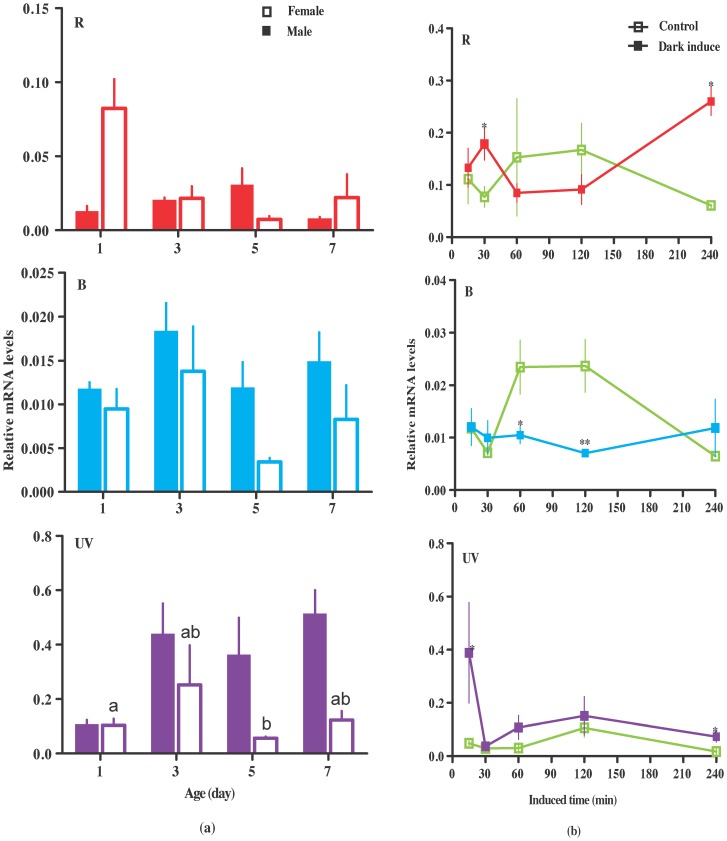
Relative expression level of R, B and UV opsins at different day instar stage of adults (a) and time of dark-treatment (b).Mean ± SE. n = 4 for each point. No significant difference occurs among different day instar stage of adults except for UV opsin in females, which is shown using different letters. The “*” and “**” denote statistical significance of the expression levels at P<0.05 and P<0.01, respectively.